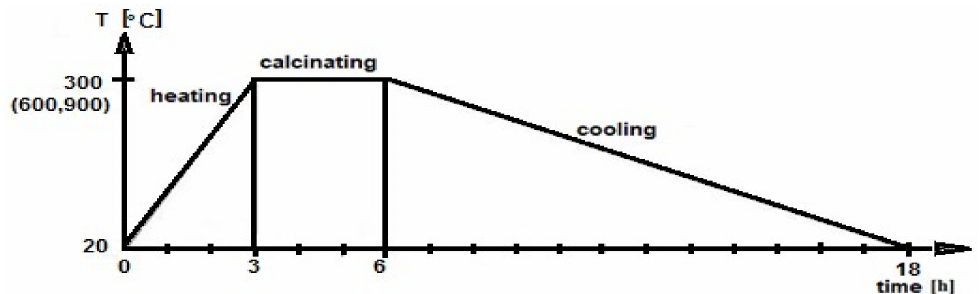
Figure 2. The heating process of recycled concrete